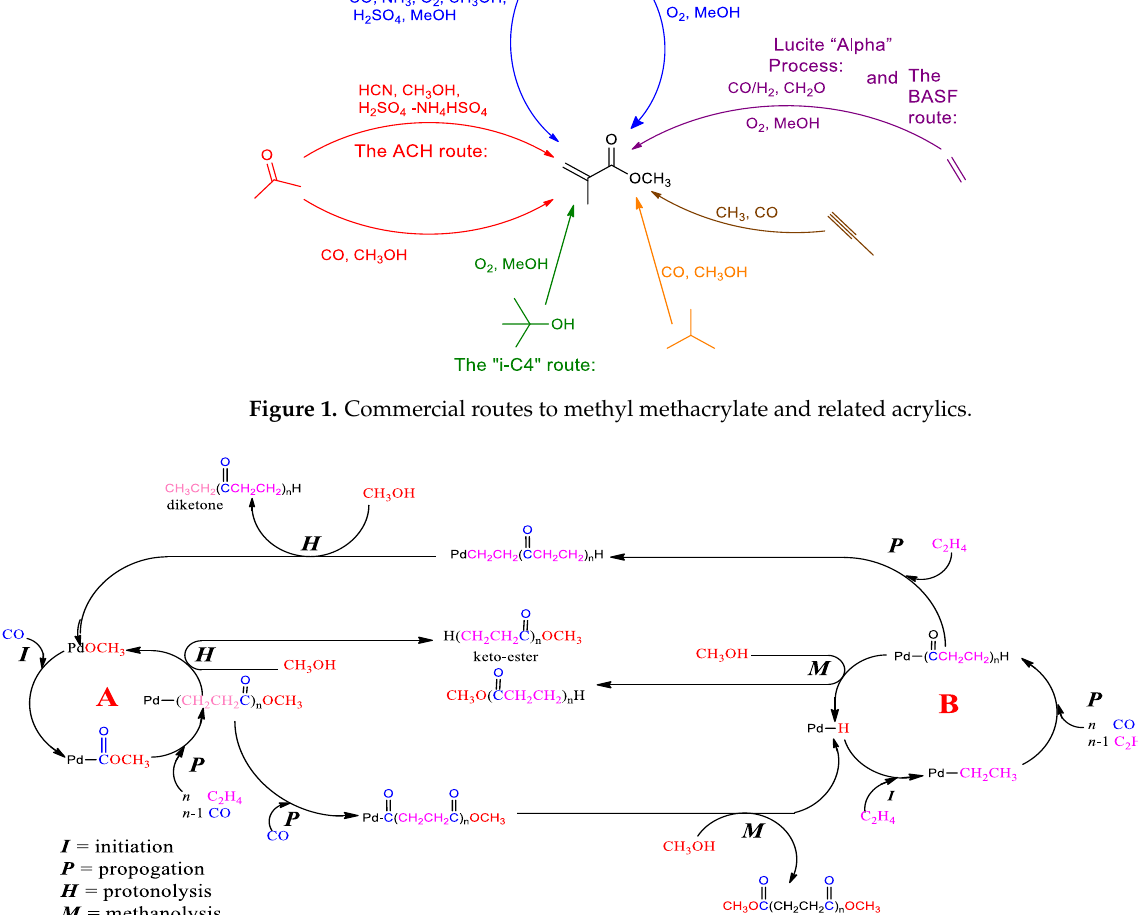
Figure 2. Products obtained from the palladium-catalysed reaction of ethene, carbon monoxide, and methanol according to Drent et al.